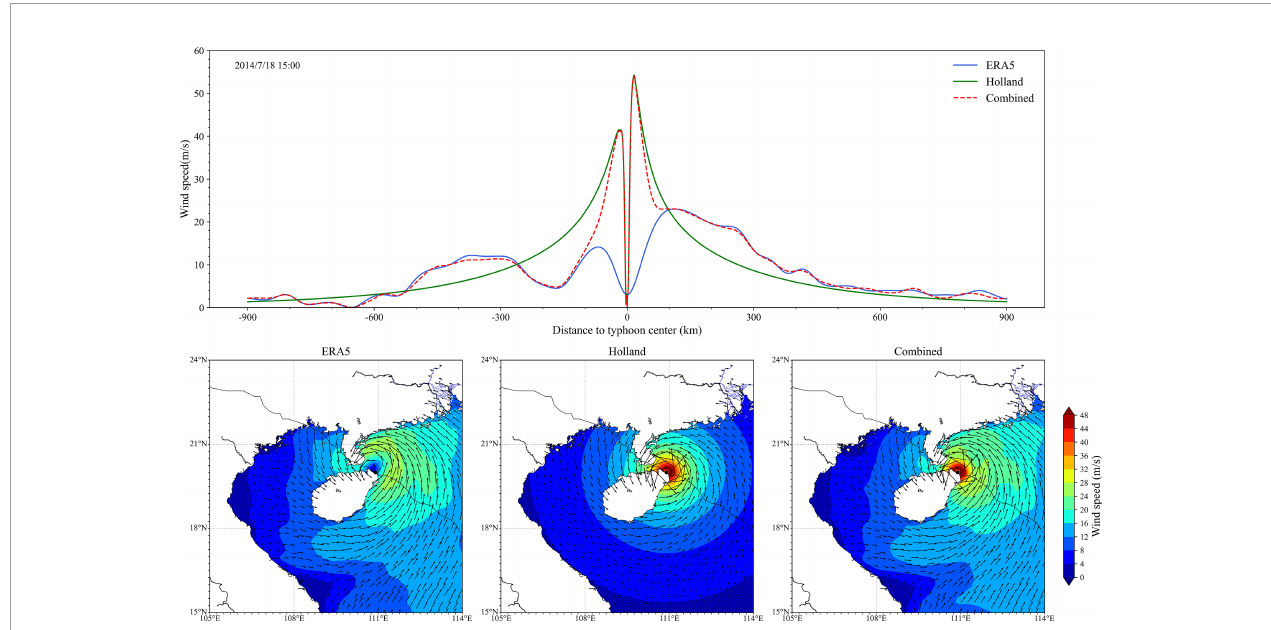
FIGURE 3 | Wind speed pro fi les (upper panel) and spatial distributions (lower panel) from different wind fi elds. The location is shown in Figure 1